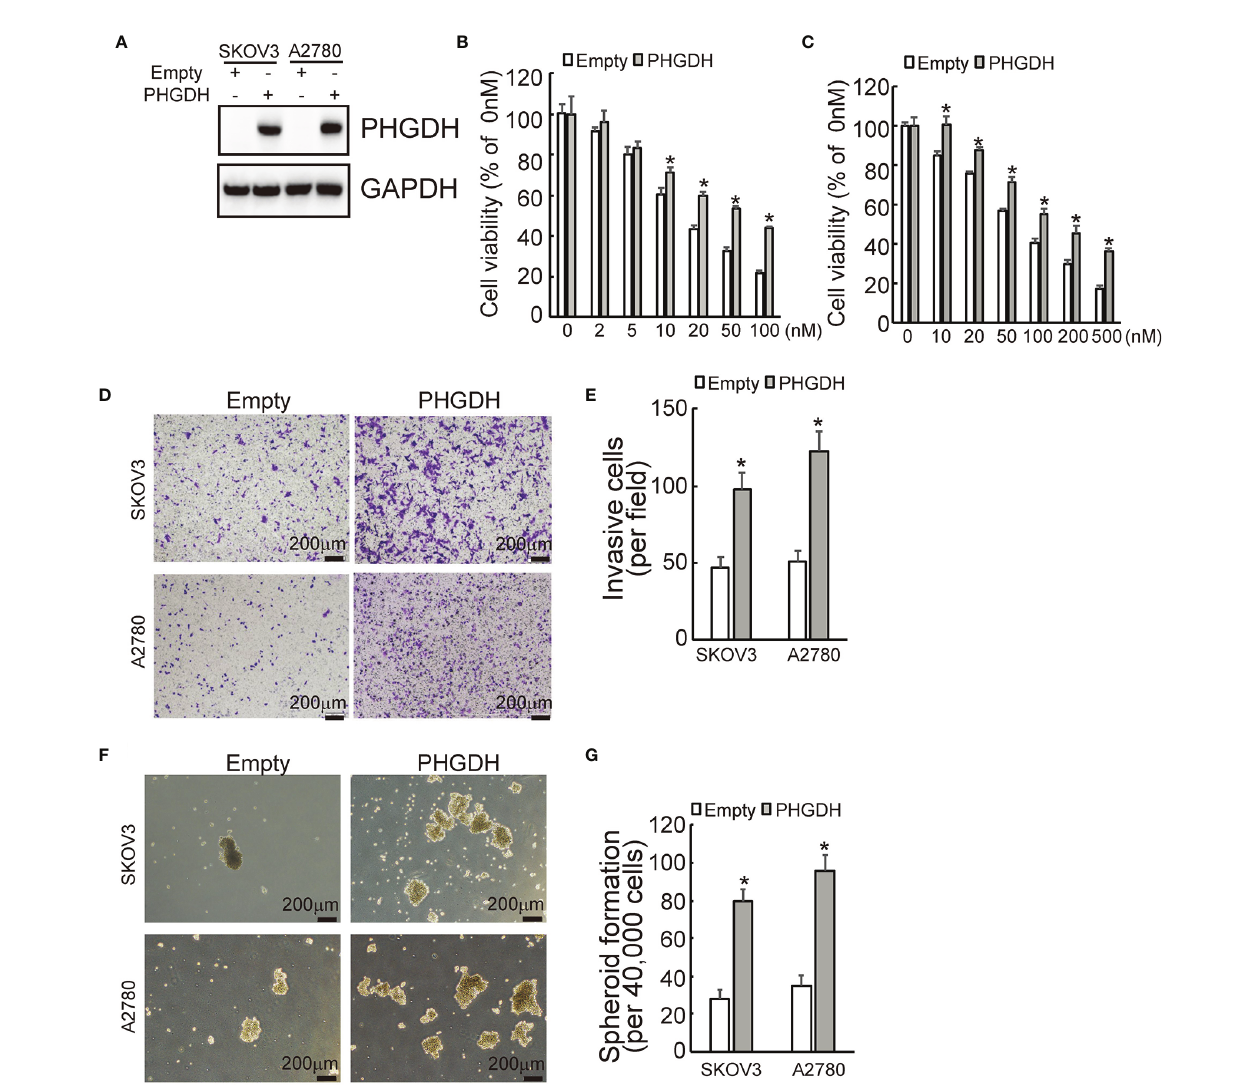
FIGURE 3 | PHGDH overexpression suppresses responsiveness to cisplatin and promotes invasion and spheroid formation of platin-sensitive ovarian cancer cells. (A) SKOV3 or A2780 cells were infected with lentivirus containing PHGDH labeled with Myc epitope (Myc-PHGDH, labeled as PHGDH) and the empty pGCLV- GV166 lentivirus vector (empty) as control, expression of PHGDH was con fi rmed by Western blot. (B, C) The indicated cells (SKOV3 or A2780 cells were infected with lentivirus containing PHGDH (PHGDH) and the empty pGCLV-GV166 lentivirus vector (empty) as control) were treated with the solvent control and were treated with different doses of cisplatin for 48 h, and cell viability was analyzed using CCK8 assays. (D, E) The indicated cells were plated on the Matrigel-coated tranwell, invaded cells were stained with crystal violet and photographed (D) , cell numbers were counted and plotted (E) . (F, G) The indicated cells were fl oating cultured with serum-free media for 14 days, spheroid was photographed (F) , and spheroid numbers were counted and plotted (G) . * P < 0.01; N.S., not signi fi